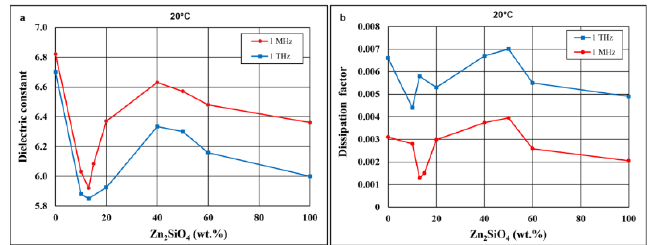
Figure 11. Dependence of dielectric constant ( a ) and dissipation factor ( b ) at 20 °C on the Zn 2 SiO 4 content in Zn 4 B 6 O 13 –Zn 2 SiO 4 composites for 1 MHz and 1 THz.